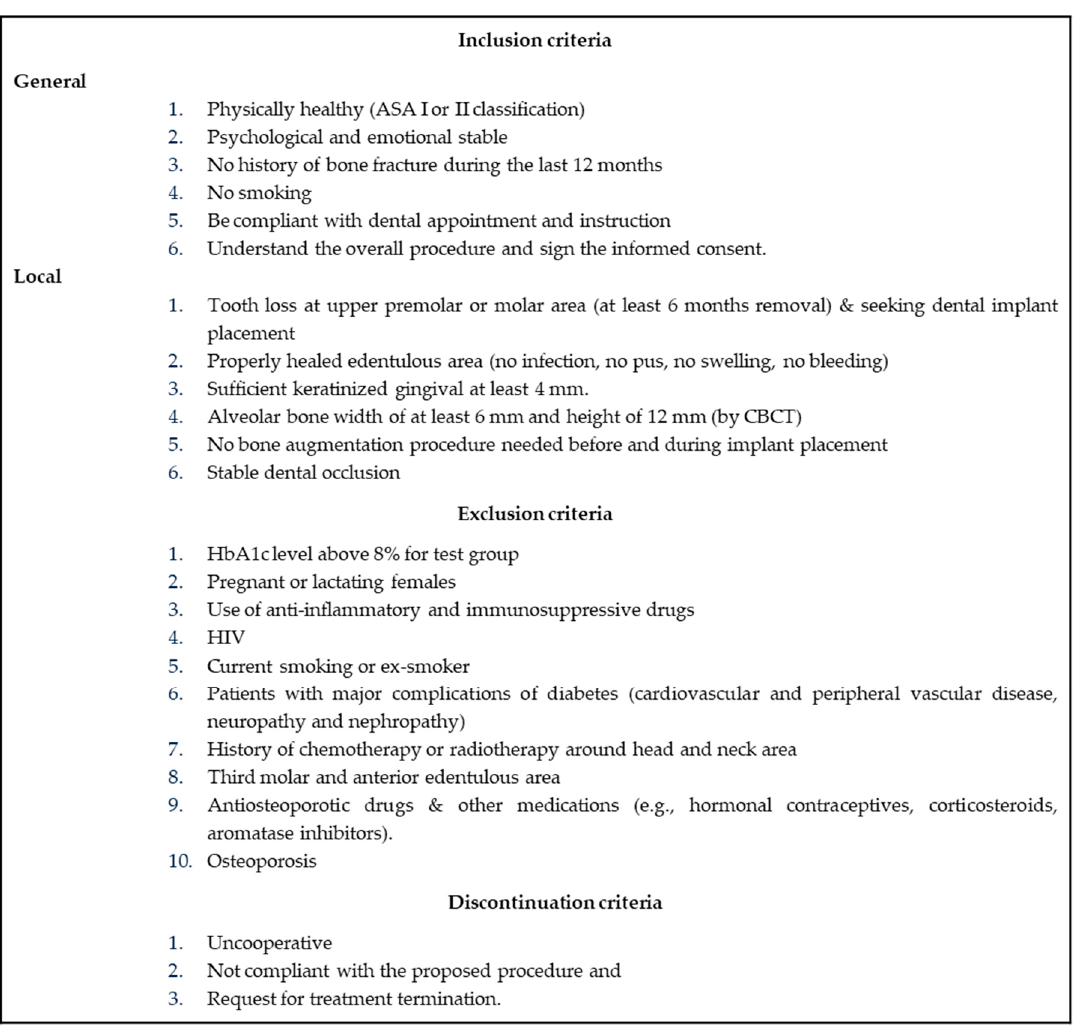
Figure 1. Criteria for participating in this study.